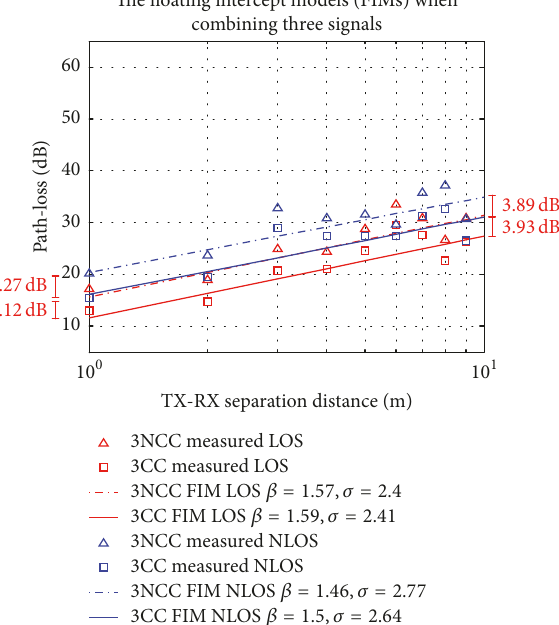
Figure 7: FIMs along with the scattered data for 1 × 3 SIMO case when considering CC and NCC for both the LOS and NLOS propagation scenarios.